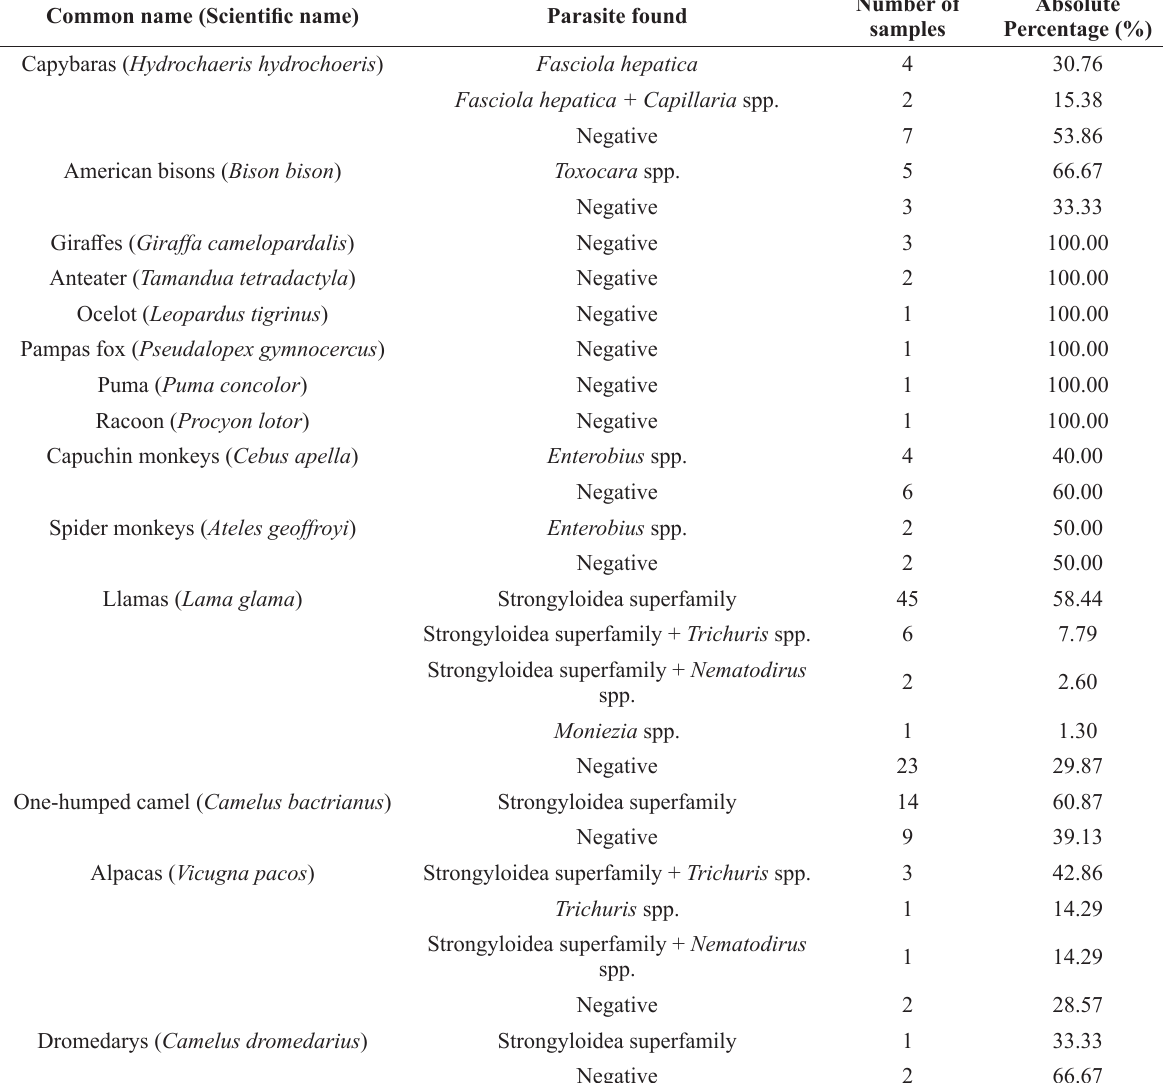
Parasites diagnosed in mammals samples of Paraná State, Brazil,